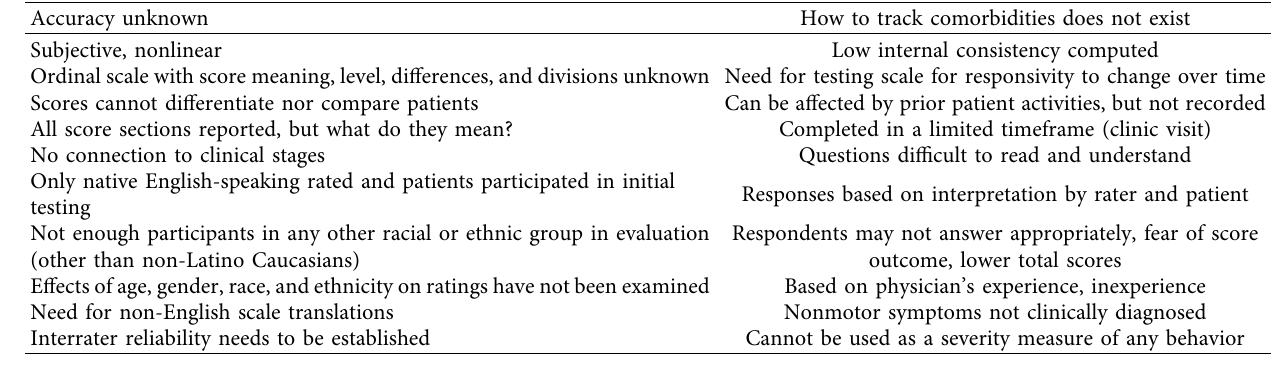
Table 2: A summary of the MDS-UPDRS limitations [4, 9,